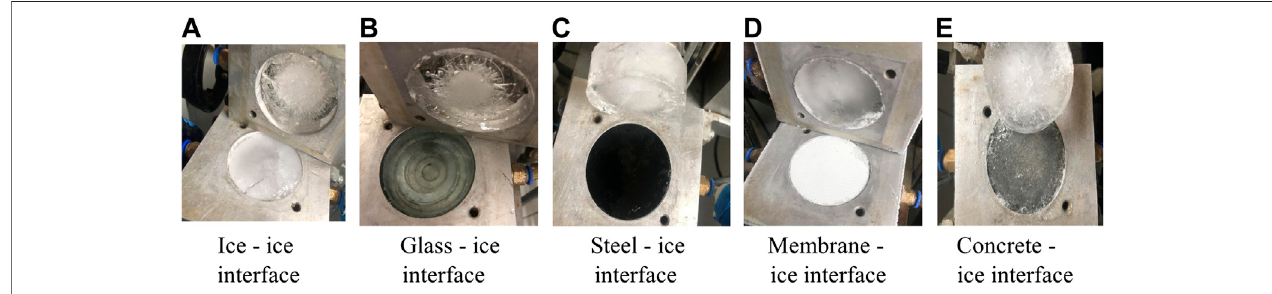
FIGURE. 6 | Specimen after shear failure: (A) ice – ice interface, (B) glass – ice interface, (C) steel – ice interface, (D) membrane – ice interface, and (E) concrete – ice interface.